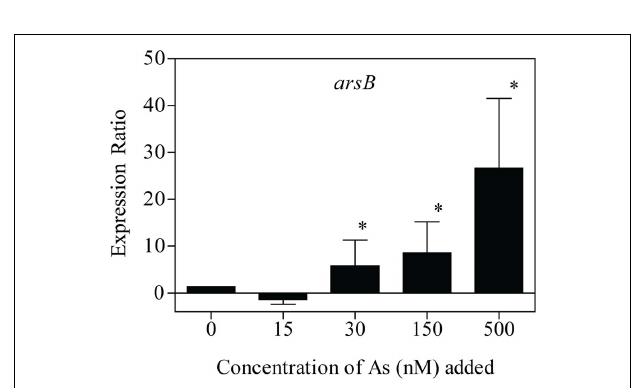
FIGURE 5 | Expression pattern for arsB as a function of arsenate additions. The expression ratio is the fold change of triplicate measurements between the sample expression and the calibrator expression (e.g., the zero time point). Error bars indicate the SE of triplicate measurements of the expression ratio. Significance ( p < 0.05) is indicated (*) for each arsenate addition treatment relative to the no addition control using a pair-wise fixed reallocation randomization analysis.